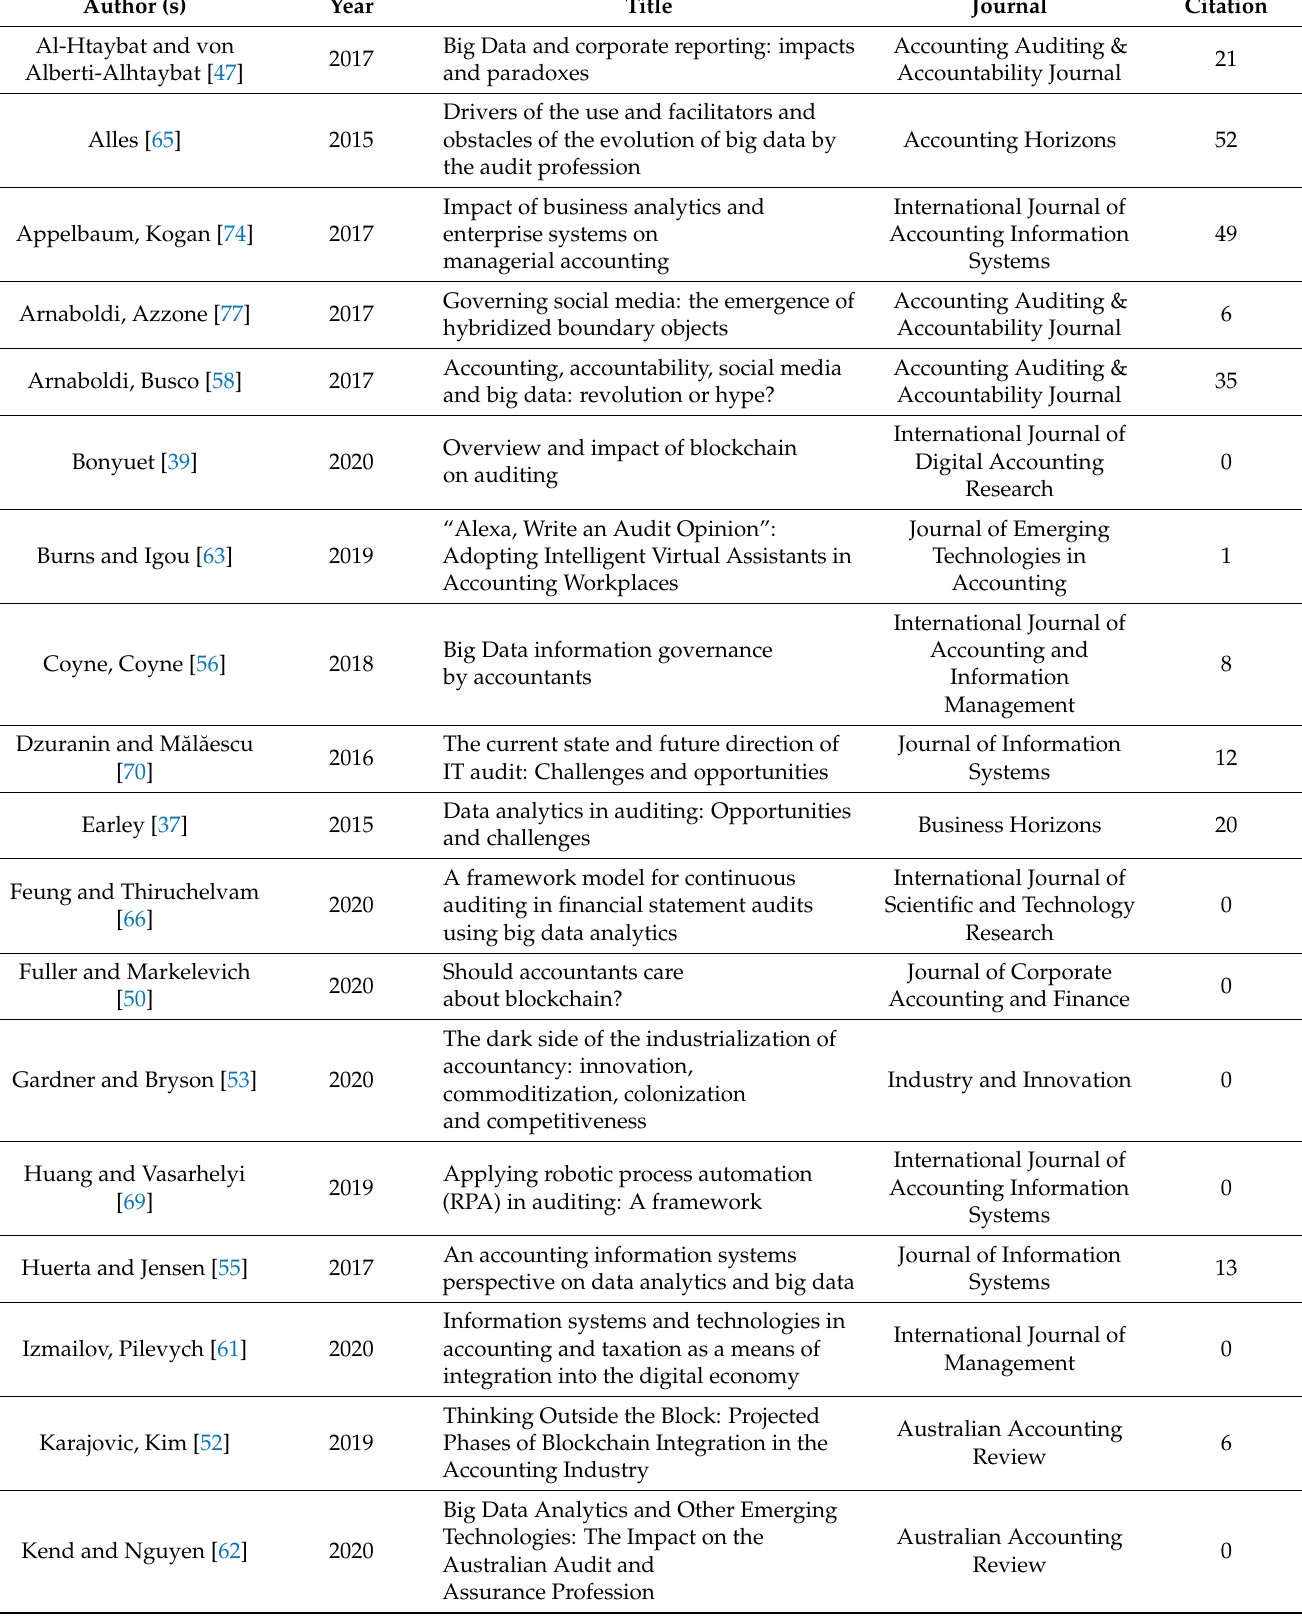
Table A1. Fundamental data about the